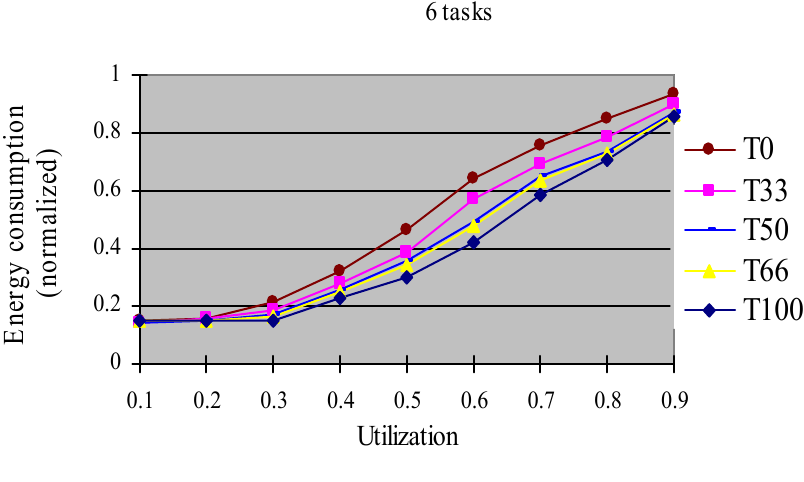
Figure 8. Normalized energy consumption at different subtask type ratio. 6